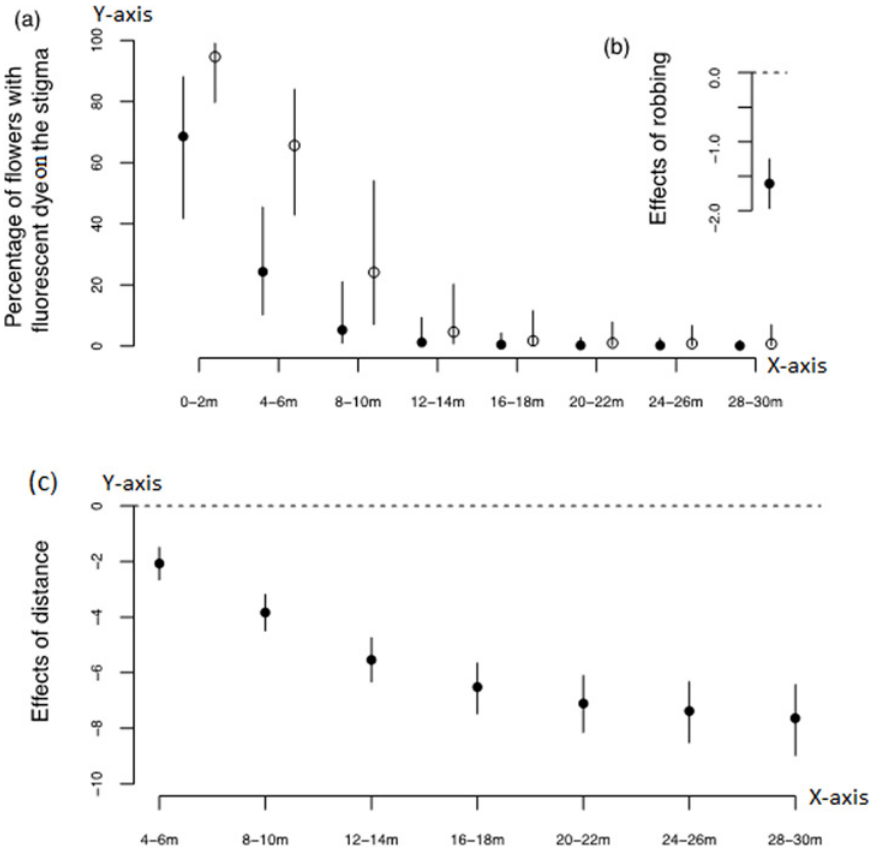
Fig 3. (a) Posterior means of florescent powder dispersal probability (%) among robbed (closed circles) and unrobbed (open circles) plots. (b) Effects of robbing on florescent powder dispersal probability (c) Effects of distances on florescent powder dispersal probability. The effects of distances were calculated with respect to that measured for 0 – 2 m (i.e., the effect for 0 – 2 m was set to zero and was used as a benchmark). Bars represent the 95% confidence interval of the posterior distribution in each figure.